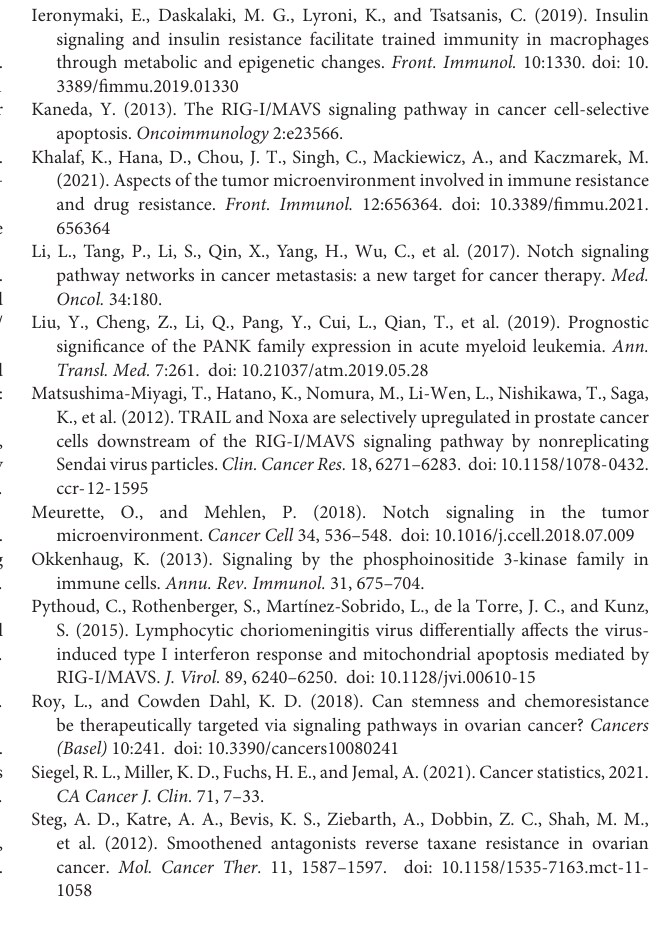
Supplementary Figure 1 | Correlation between MAVS expression and infiltrating immune cells. (A) Linear relationship between MAVS expression and CD8 T cells. (B) Linear relationship between MAVS expression and eosinophils. (C) Linear relationship between MAVS expression and activated memory CD4 T cells. (D) Linear relationship between MAVS expression and resting memory CD4 T cells. Supplementary Table 1 | Genes in the dark green module were highly correlated with MAVS by WGCNA